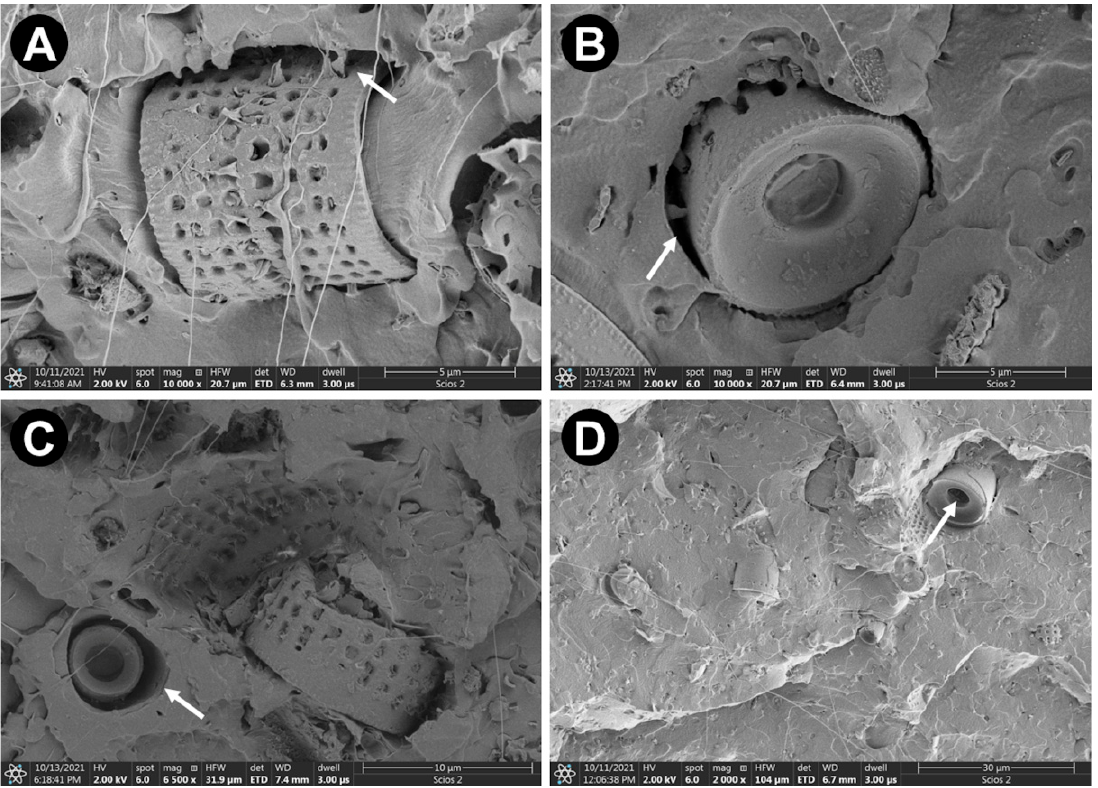
Figure 4. SEM images of the voids ( white arrows ) in manufactured composites: ( A ) 2003-10, ( B ) 3001-5, ( C ) 3251-15, ( D ) 4043-5.